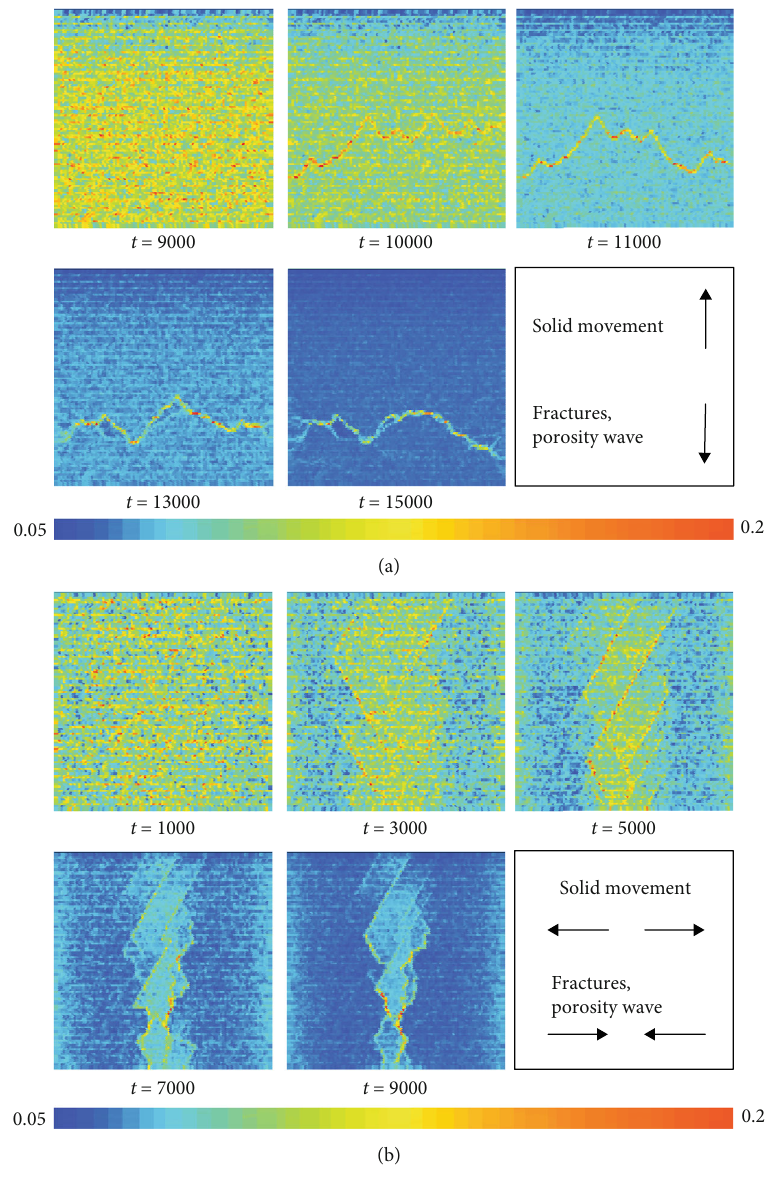
Figure 5: Porosity evolution of scenarios 1 and 2. (a) Scenario 1 shows a pressure wave that develops horizontally and moves gradually downwards. (b) Scenario 2 shows the development of a vertically aligned porosity wave with high porosity in the center surrounded by two compacted zones. In the high-porosity center, mobile porosity channels open and close to drain the system vertically. Movement of the solid and the porosity for the two scenarios is shown in two